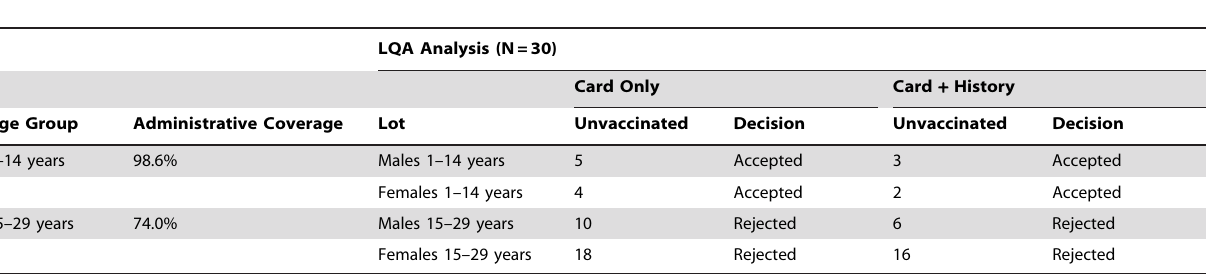
Table 3. Vaccination coverage results in persons aged 1–29 years for Phase I of the first phase of the MenAfriVac introduction campaign presented by administrative coverage and Lot Quality Assurance (LQA) analysis, Filingue, Niger, October